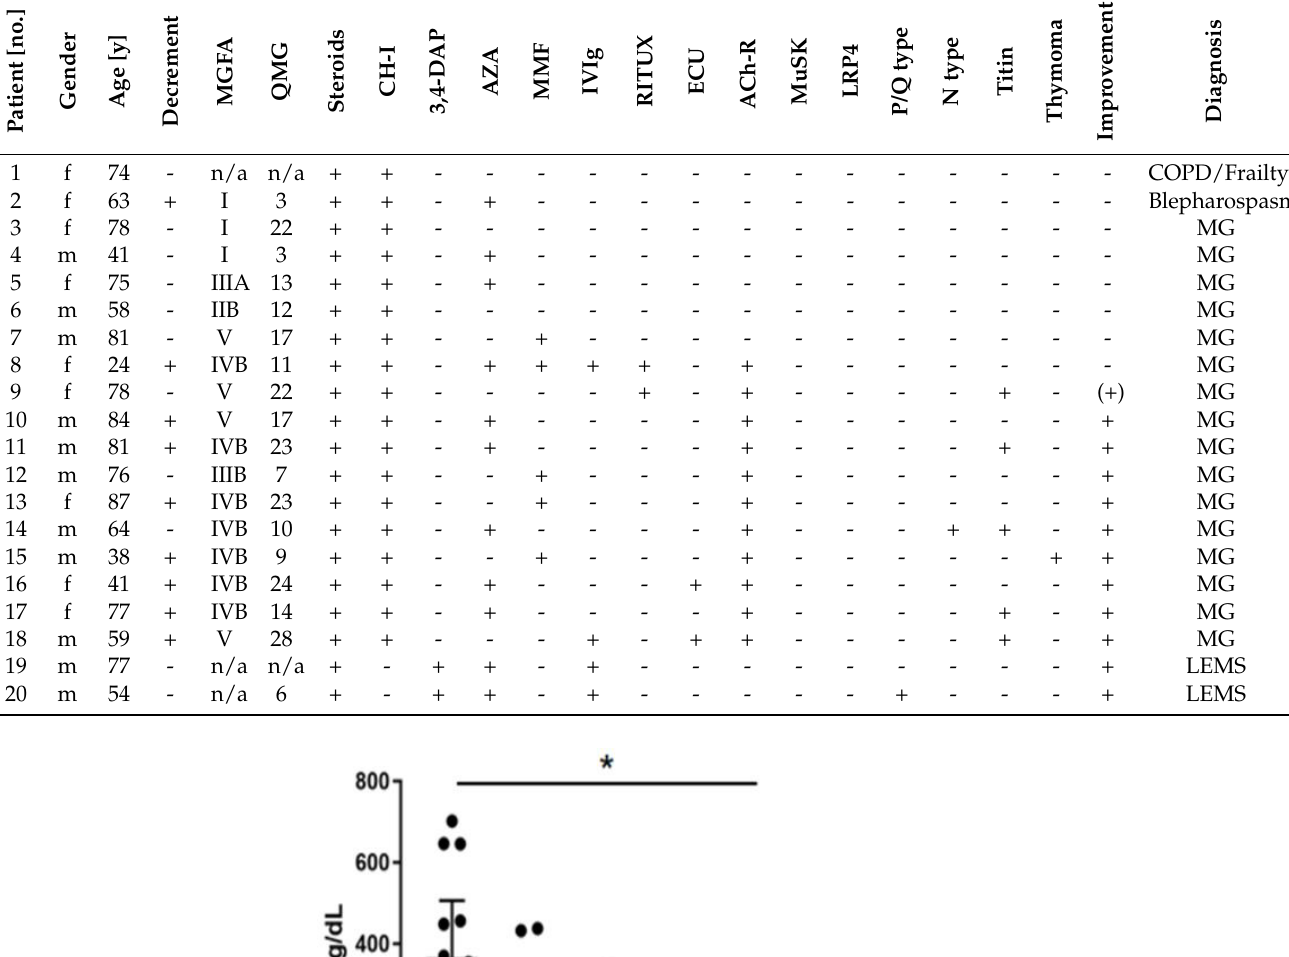
Figure 3C,D). None of the patients needed a blood transfusion due to the TPE procedure. Table 2. Patients who were treated with total plasma exchange. f = female; m = male; MGFA = Myasthenia Gravis Foundation of America classification; QMG = Quantitative Myasthenia Gravis score; CH-I = cholinesterase inhibitors; 3,4-DAP = 3,4-diaminopyridine; AZA = azathioprine; MMF = mycophenolate mofetil; IVIG = intravenous immunoglobulin; RITUX = rituximab; ECU = eculizumab; ACh-R = acetylcholine receptor (antibodies); MUSK = muscle-specific kinase (antibodies); LRP4 = low-density lipoprotein receptor-related protein 4 (antibodies); P/Q or N type (voltage-gated calcium channel antibodies); Titin (antibodies); MG = myasthenia gravis; LEMS = Lambert–Eaton myasthenic syndrome; COPD = chronic obstructive pulmonary disease.